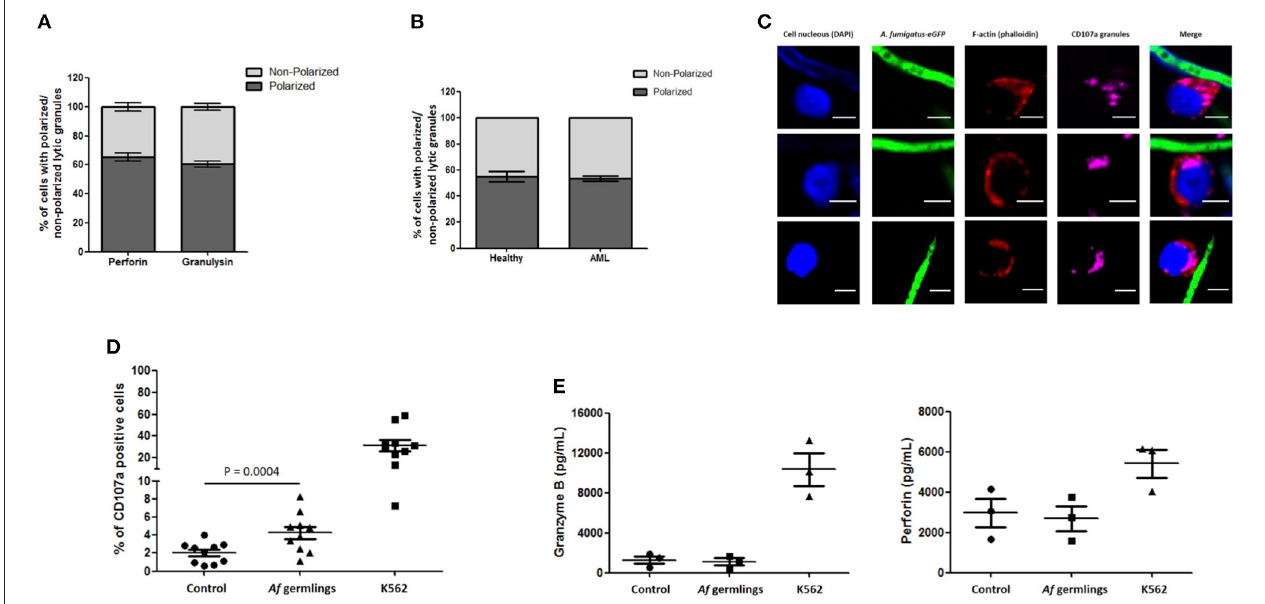
FIGURE 3 | NK cell granule release is impaired during direct contact with A. fumigatus hyphae (A) . Percentage of perforin- and granulysin-containing granules polarisation in NK cells co-incubated with A. fumigatus . The graph displays the percentage of perforin and granulysin polarisation toward A. fumigatus . Isolated primary human NK cells were challenged with A. fumigatus overnight at MOI = 0.05. Cells were then fixed, stained for perforin or granulysin and analysed by confocal microscopy. Bar graph shows the mean ± SD of three independent experiments. (B) AML NK cell incubation with A. fumigatus induces normal granule polarisation toward the fungus. NK cells isolated from healthy donors or from AML patients were challenged with A. fumigatus overnight at MOI = 0.05. After the incubation period, cells were fixed, stained for CD107a and analysed by confocal microscopy. The graph displays the percentage of CD107a polarisation toward A. fumigatus . Bar graph shows the mean ± SD of three independent experiments. (C) AML NK cell granules polarise toward A. fumigatus in vitro . Representative images of primary human NK cells from AML patients incubated overnight with A. fumigatus GFP germlings at MOI = 0.05. After the incubation period, cells were washed, fixed, permeabilised, and stained for CD107a. Phalloidin staining is indicated in red, the nuclei are indicated in blue, CD107a staining is indicated in magenta and A. fumigatus GFP is shown in green. Scale bars = 5 µ m. (D) NK cell challenge with A. fumigatus leads to increased cell surface CD107a expression. Isolated human